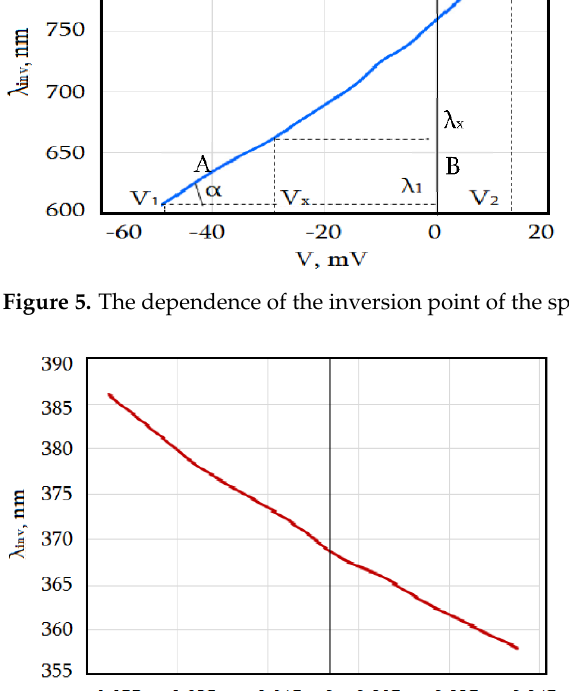
Figure 6. The dependence of the inversion point of the spectral photocurrent on the bias voltage in the short-wave region of the spectrum.